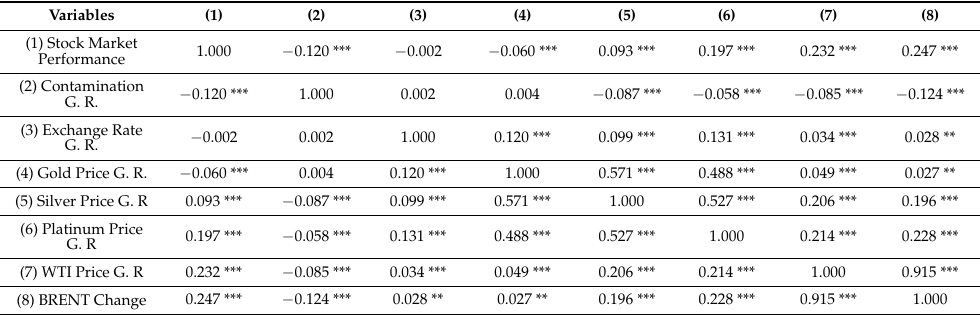
Table 1. Correlation Matrix.